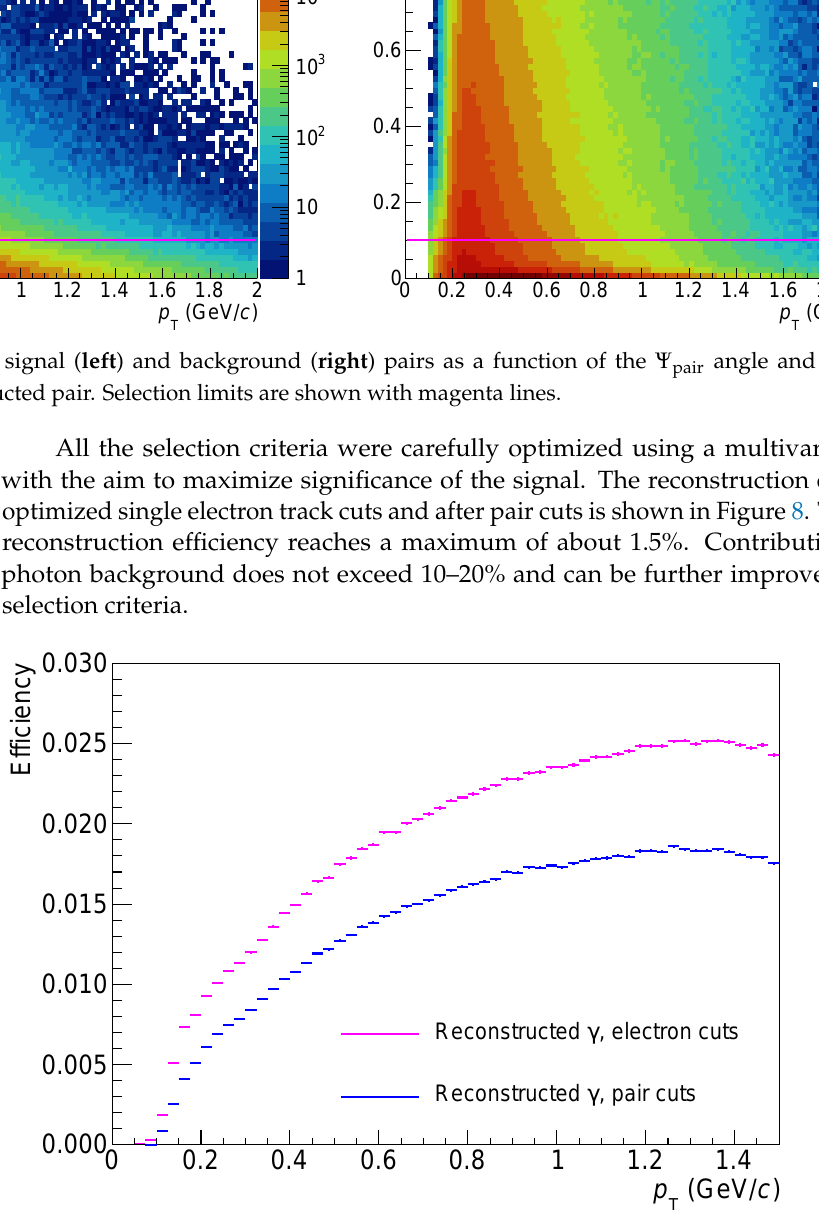
Figure 8. Photon reconstruction efficiency after single electron (magenta) and electron pair (blue) selection